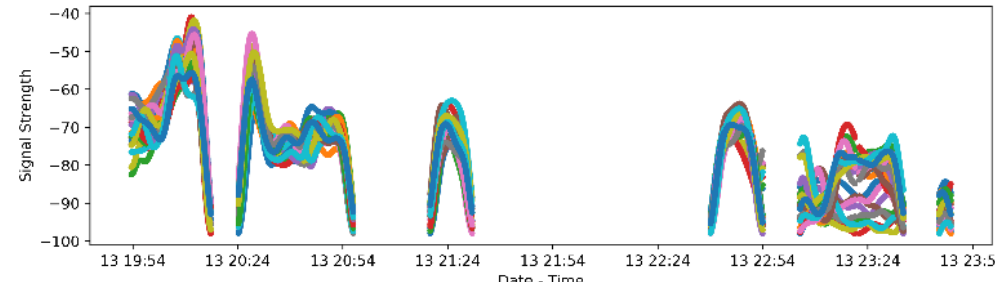
Figure 4. Signal of different iBeacons follow the same trend on the 13th of the month until around 23:00, indicating that they are in the original box provided by the clinician. After 23:00 signals have different trends indicating that iBeacons are set up in different rooms. Note that this is the first day that the participant received the iBeacons, and the devices stayed in the participant’s household for three months (as long as the duration of the clinical study).